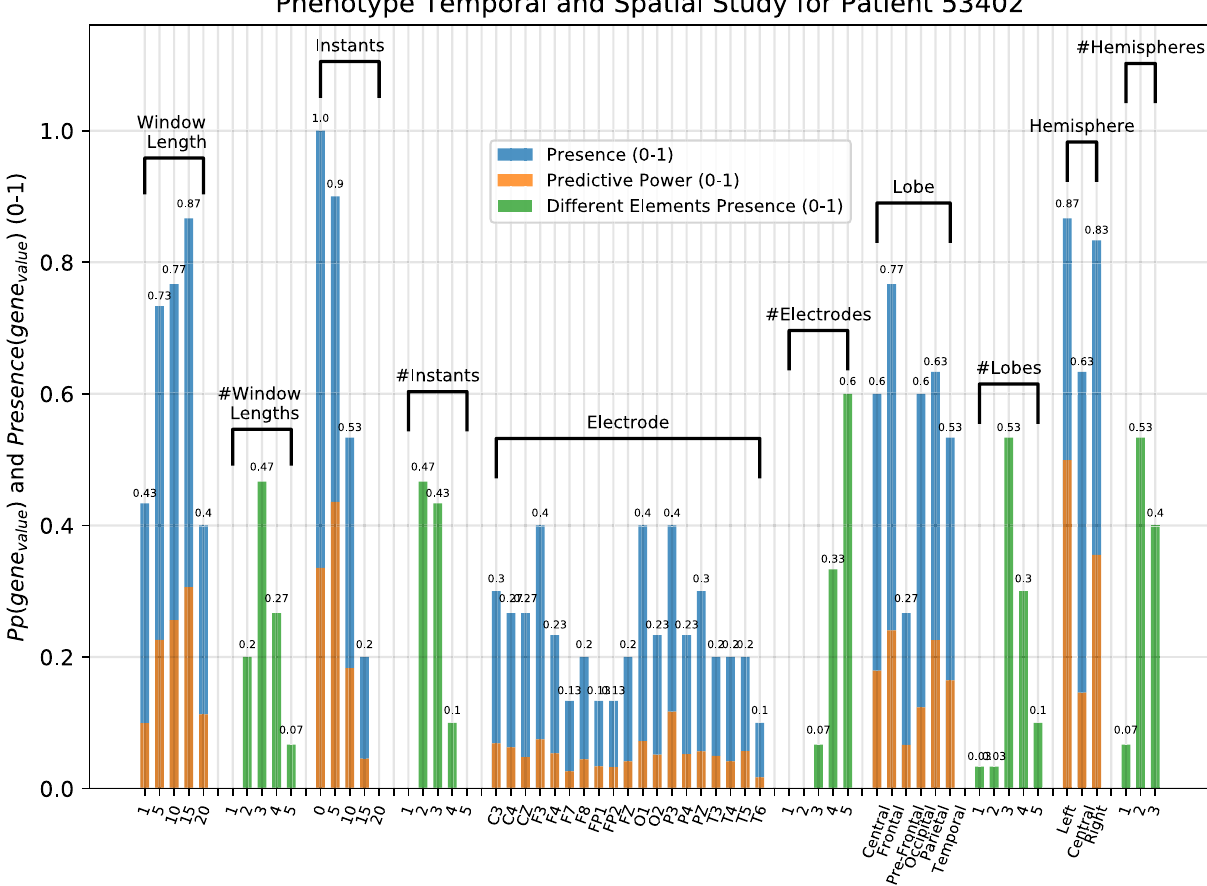
Figure 6. Phenotype temporal and spatial study for patient 53402. The presence and predictive power of temporal (window length and time instant) and spatial (electrode, lobe, and hemisphere) gene values are presented in blue and orange, respectively. The simultaneous presence of different gene values is presented in